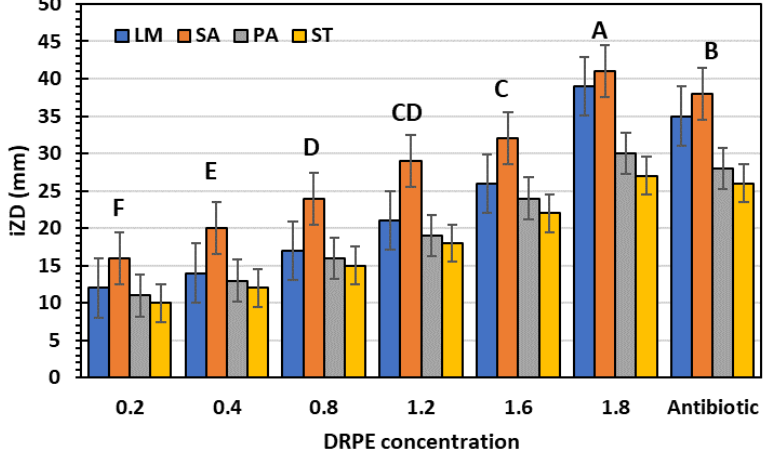
Figure 9. Inhibition zone diameters of DRPE with different concentrations against pathogenic bacteria compared to a bacterial antibiotic after one day of incubation at 37 ◦ C. Uppercase letters above the columns indicate significant differences at a 5% probability